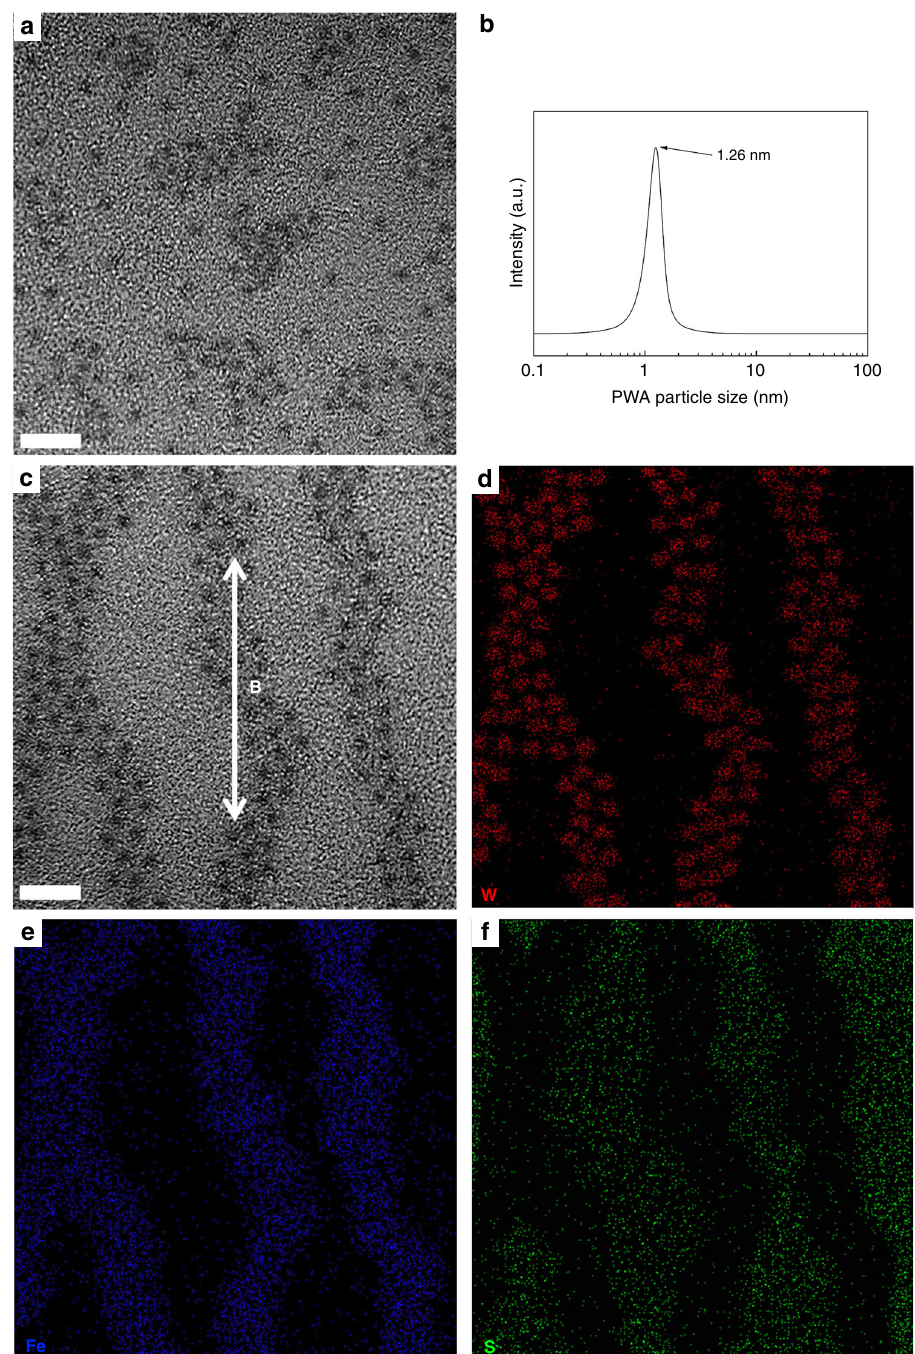
Fig. 7 Membrane cross-sectional images, mappings, and fi ller particle size estimation. a TEM image of NM-45PC showing a random dispersion and agglomeration of PWA particles (5 nm scale bar). b PWA particle size (dispersed in benzene) estimation by DLS technique. The PWA nanoparticle diameter of 1.26 nm is in good accordance with size estimation from the TEM images. c TEM image for MM-45PC (5 nm scale bar). Directionally orientated chains of PWA particles are observed, and the halo-like areas located around the PWA particles are CP4VP domains. The unpopulated regions correspond to PSf domains. d Tungsten (W) mapping for the same region in c . e Iron (Fe) mapping for the same region in c . f Sulfur (S) mapping for the same region in c . TEM: transmission electron microscopy; EELS: electron energy loss spectroscopy; DLS: dynamic light scattering; CP4VP: ferrocyanide- coordinated poly(4-vinylpyridine); PWA: phosphotungstic acid; PSf: polysulfone; NM-45PC: normal-cast membrane with 45 wt% loading of proton- conducting components; MM-45PC: magnetic-cast membrane with 45 wt% loading of proton-conducting components. Source data are provided as a Source Data fi